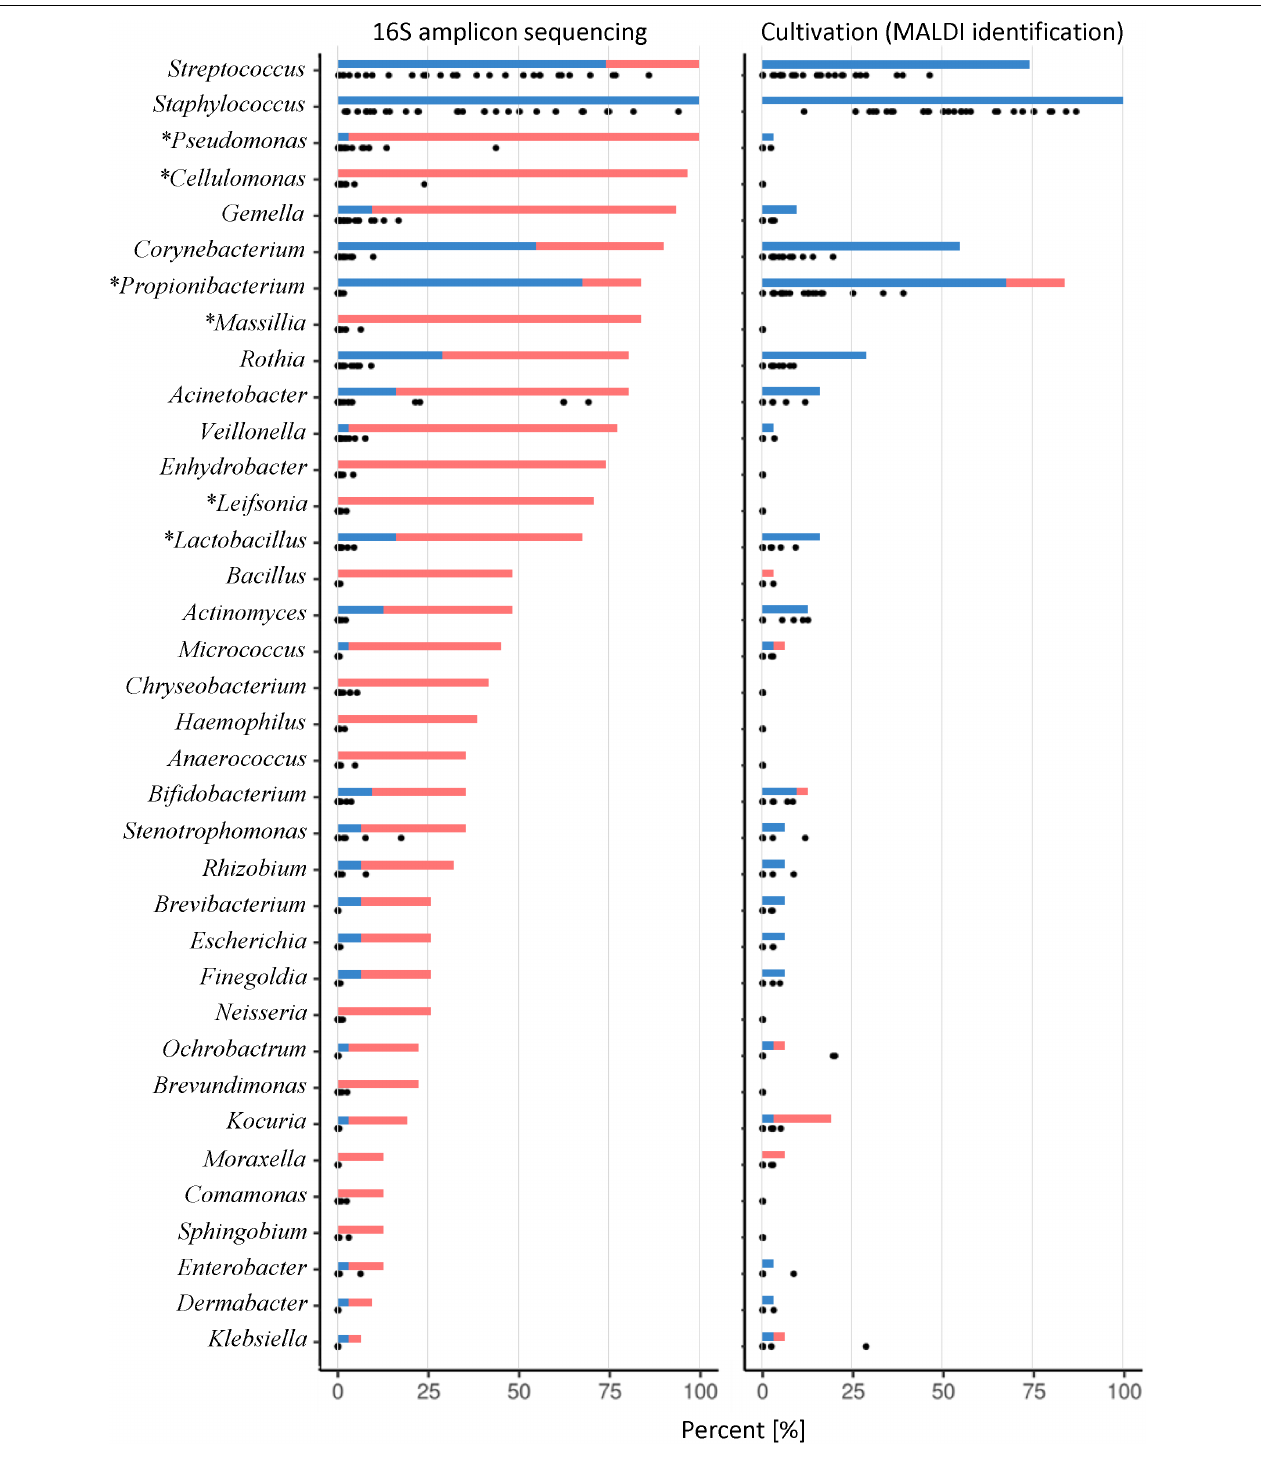
FIGURE 3 | Prevalence and relative abundance of genera detected in HMM. Either 16S rRNA gene NGS (left) or cultivation with MALDI-TOF MS identification (right) were used. Graph presents all genera detected with 16S NGS with overall relative abundance > 0.1% and additionally those detected with cultivation. Solid bars show the prevalence of a specific genus. The blue line shows the prevalence of samples where genus was detected with both sequencing and cultivation approach while the red line shows the prevalence of samples where genus was detected with only one approach [16S rRNA gene NGS (left) or cultivation (right) ]. Dots represent the relative abundance for each analyzed sample separately ( n = 31). An asterisk by the genus name indicates that at least one representative of genus was most likely present as a contamination.